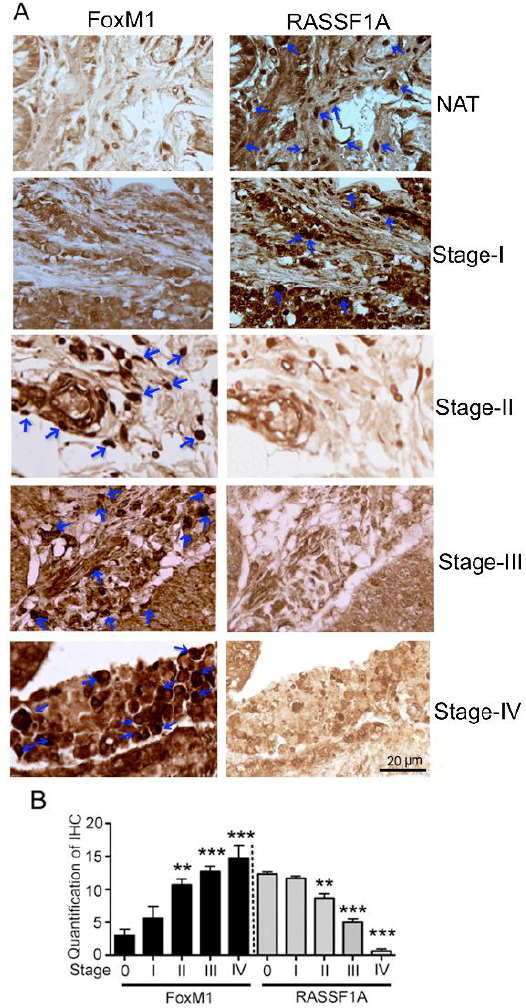
Figure 3. FoxM1 and RASSF1A expression in human tissue. ( A ) Immunohistochemical staining of FoxM1 and RASSF1A in different stages of primary colon carcinoma. (NAT): cancer adjacent normal colon tissue; (Stages I–IV): different stages of colon cancer tissue (400 × magnification time). The histogram ( B ) represents the average percentage of FoxM1 and RASSF1A expression.